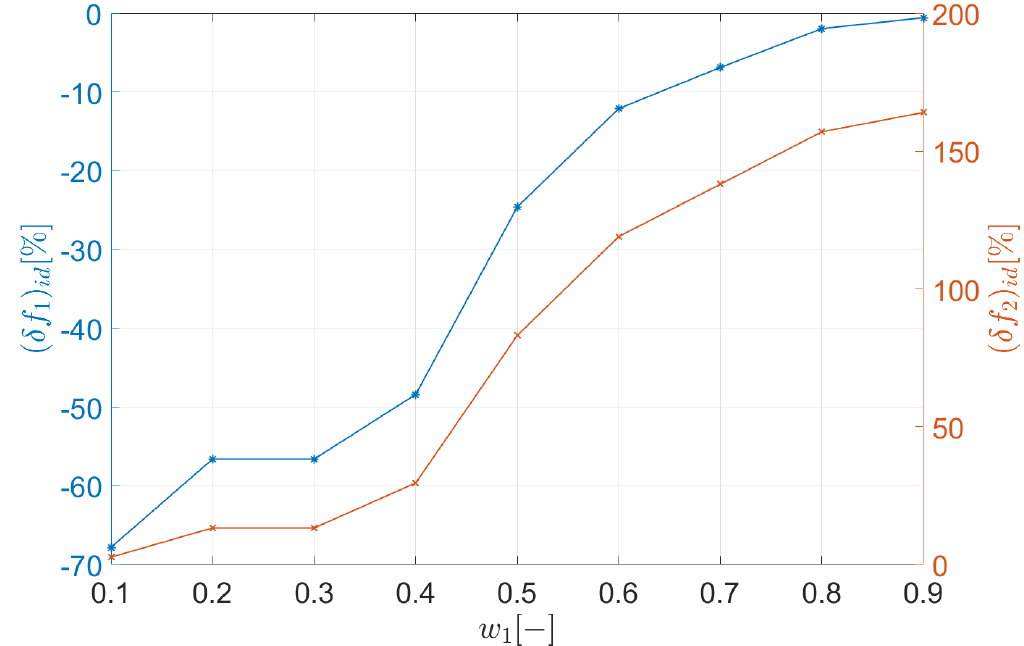
Figure 11. Deviations from an ideal solution for different sets of weights.